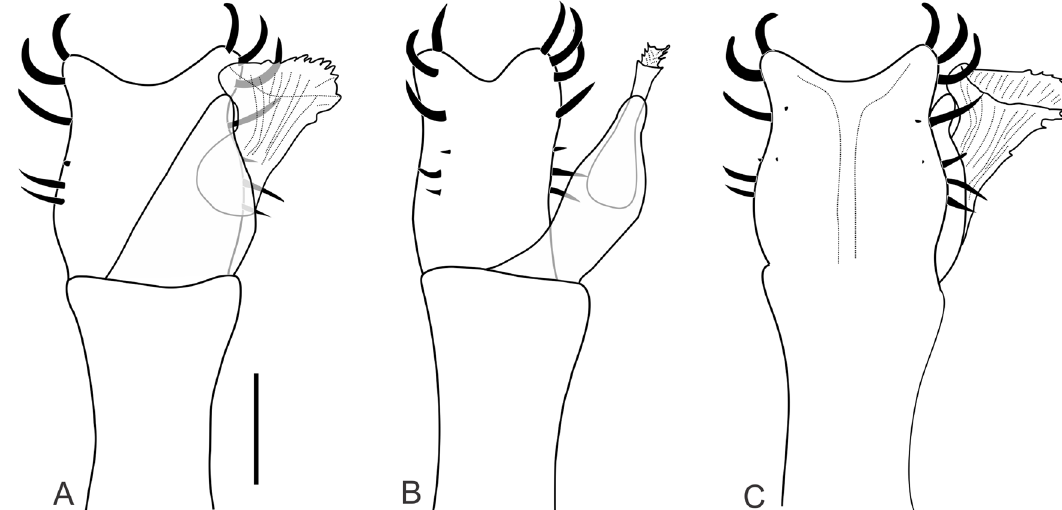
Fig. 10. Libitia gandalf sp. nov., holotype (IAvH-I-69), distal part of penis. A . Dorsal view. B . Latero- dorsal view. C . ventral view. Scale bar = 50